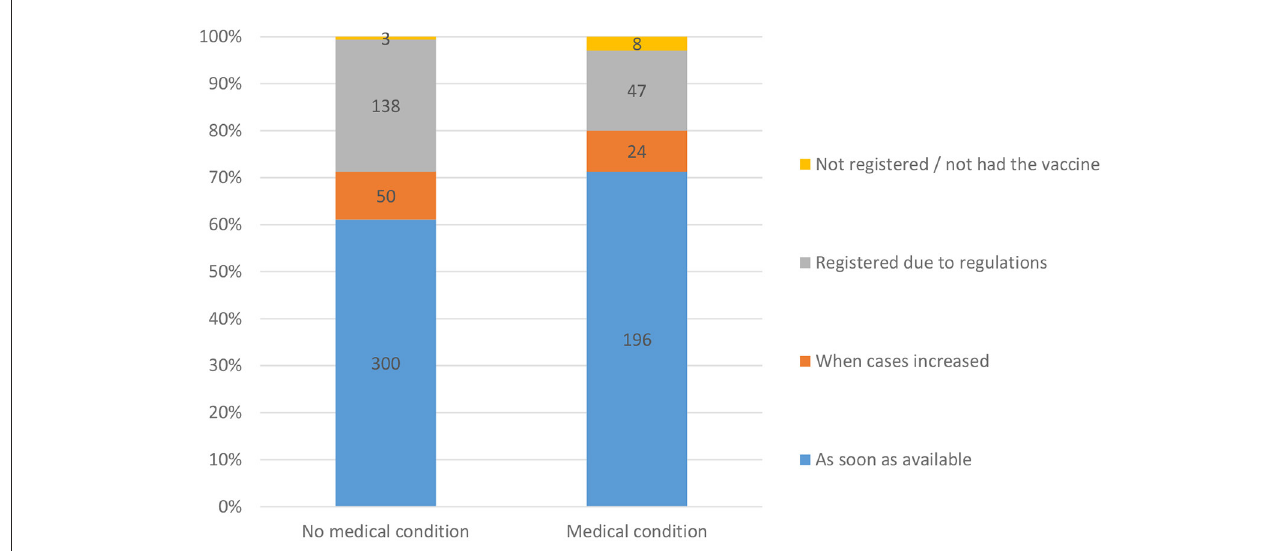
FIGURE4 Respondents’ willingness to register for vaccination as per the present or absence of medical condition.